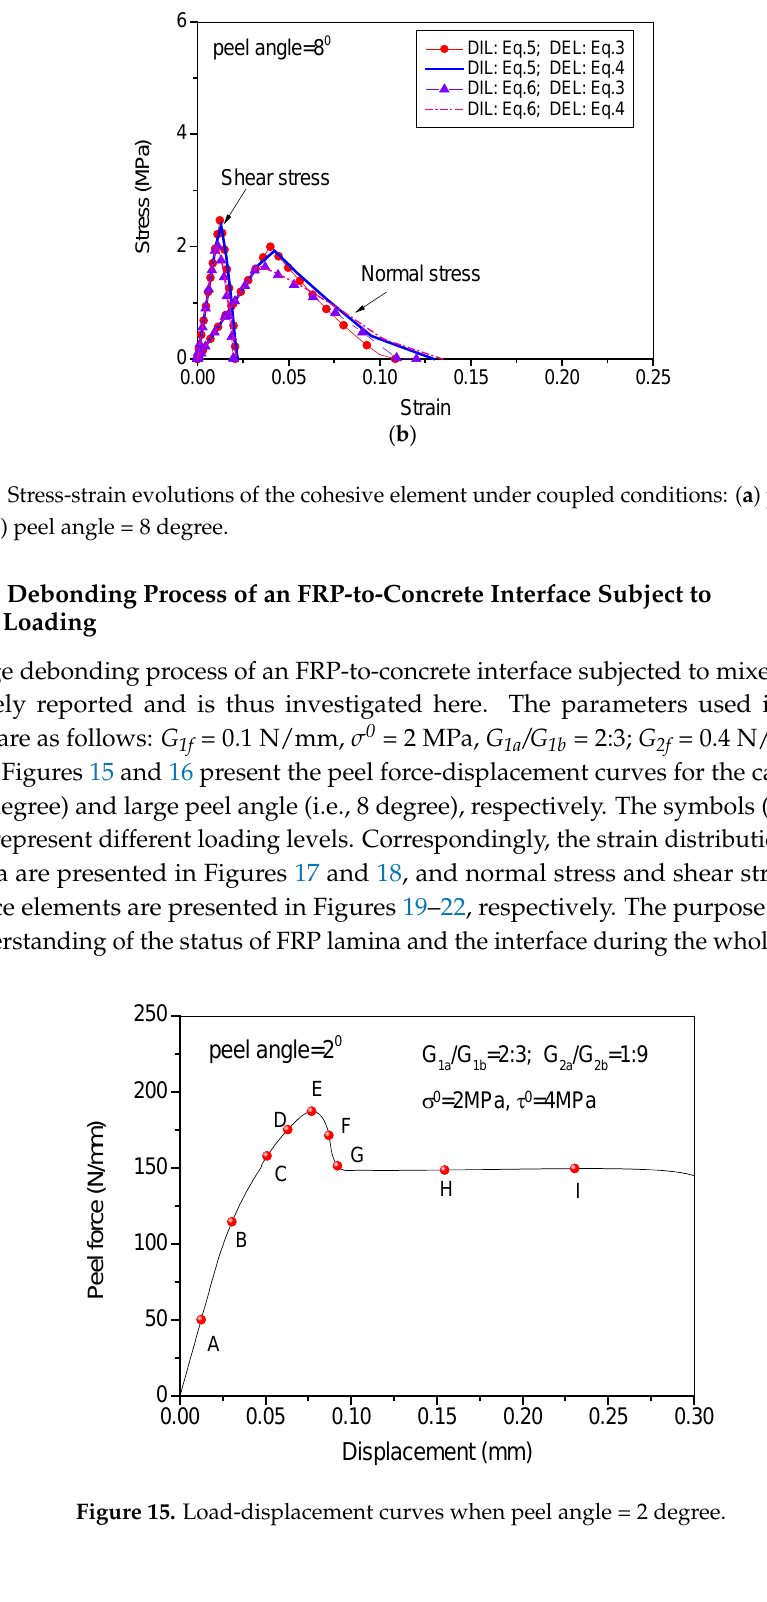
Figure 15. Load-displacement curves when peel angle = 2 degree.